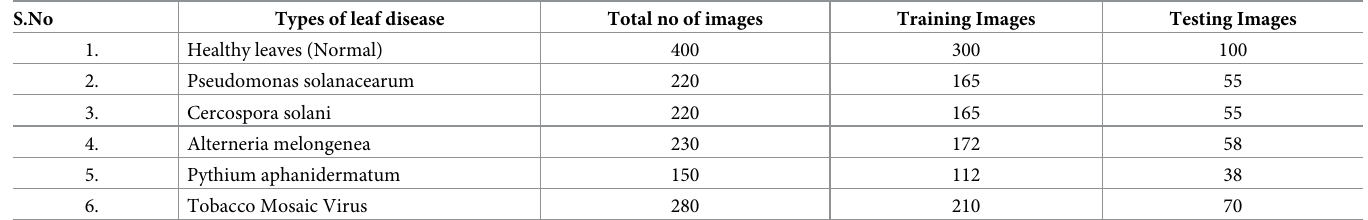
Table 7. Distribution of leaf images used in classification.